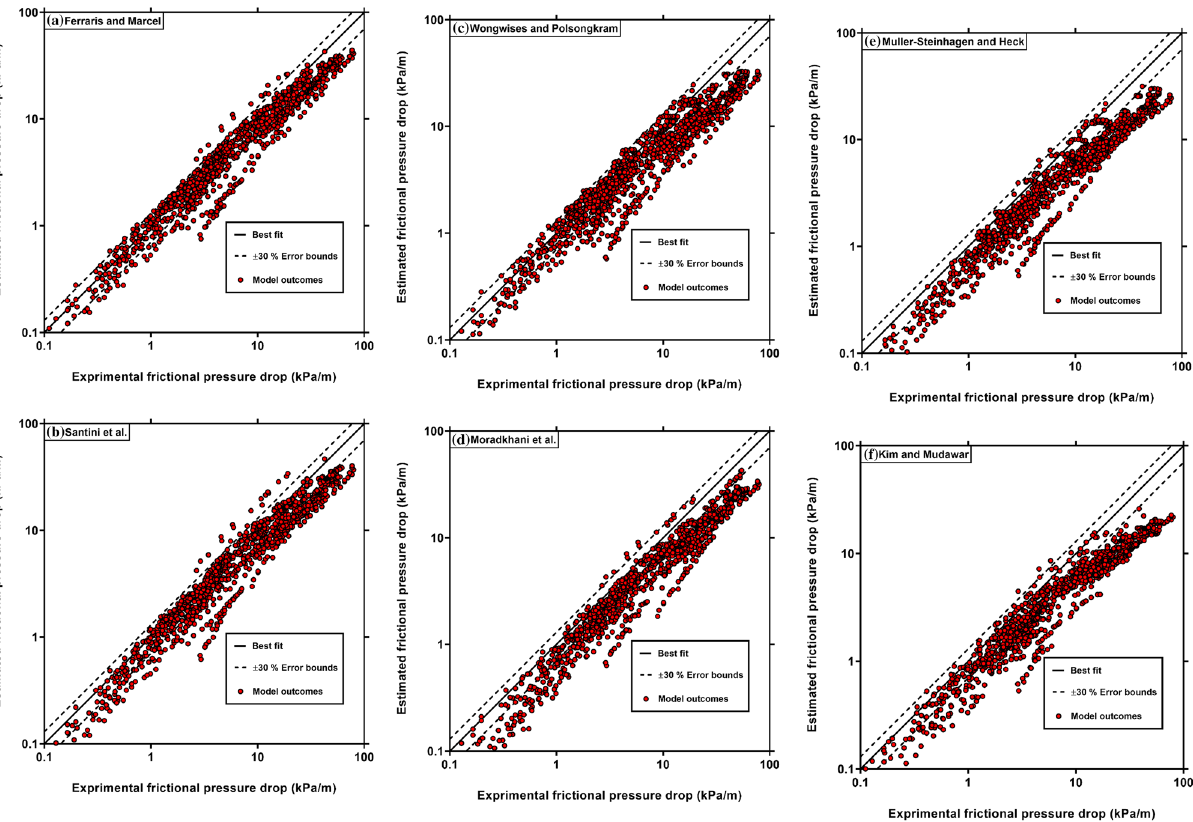
Figure 4. Comparison of the experimental FPD data with those estimated by the previous